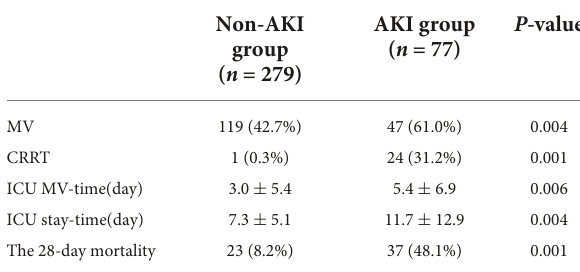
TABLE 5 Clinical outcomes with the two